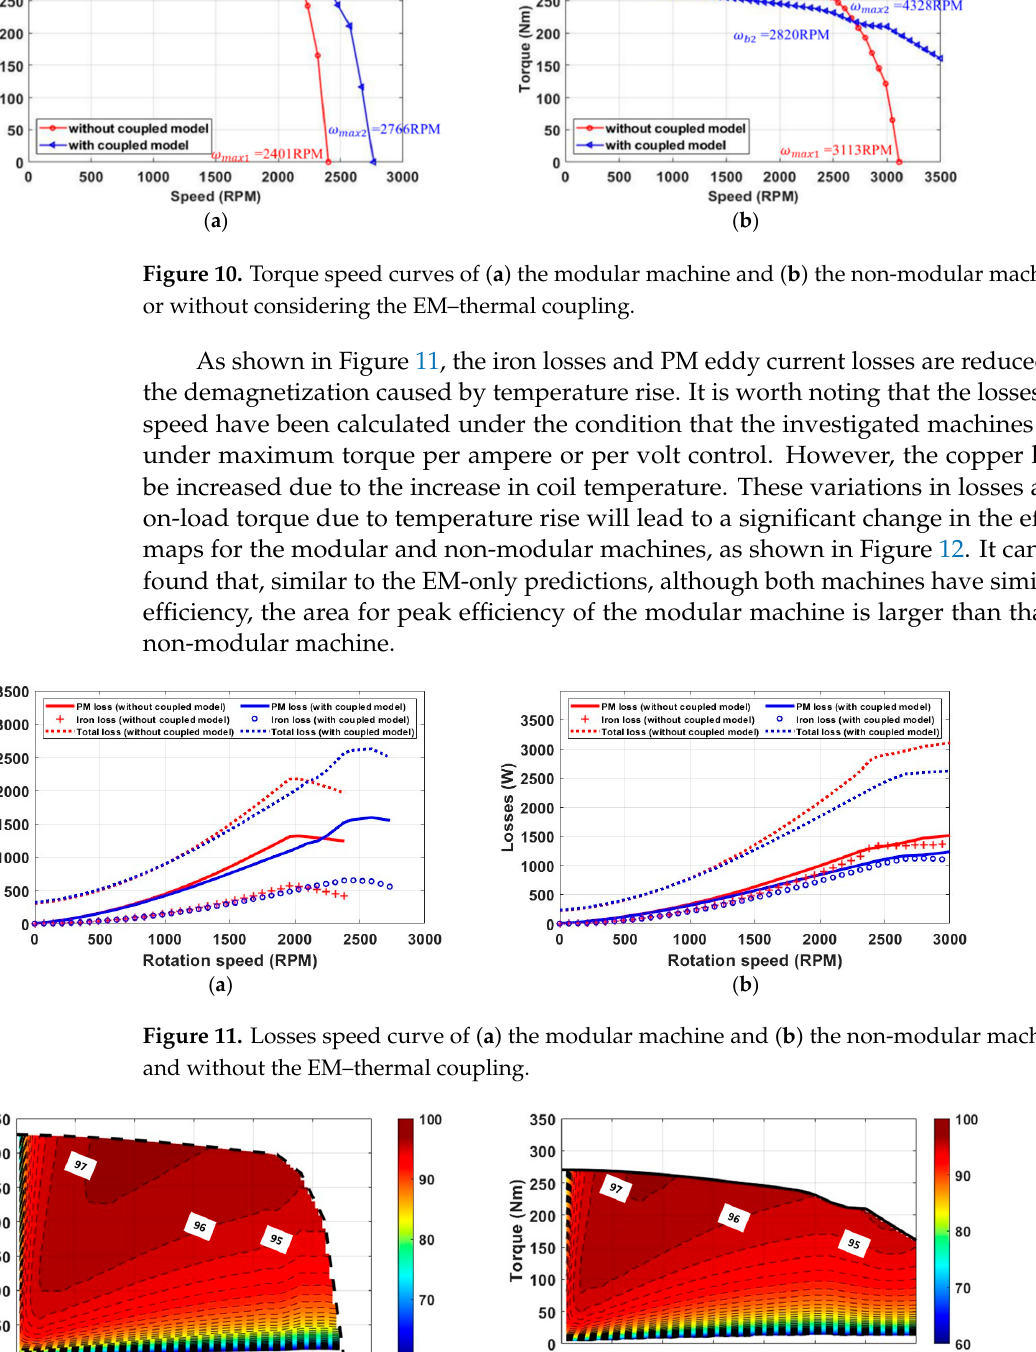
Figure 12. Efficiency maps of ( a ) the modular machine and ( b ) the non-modular machine consider- ing the EM–thermal coupling.